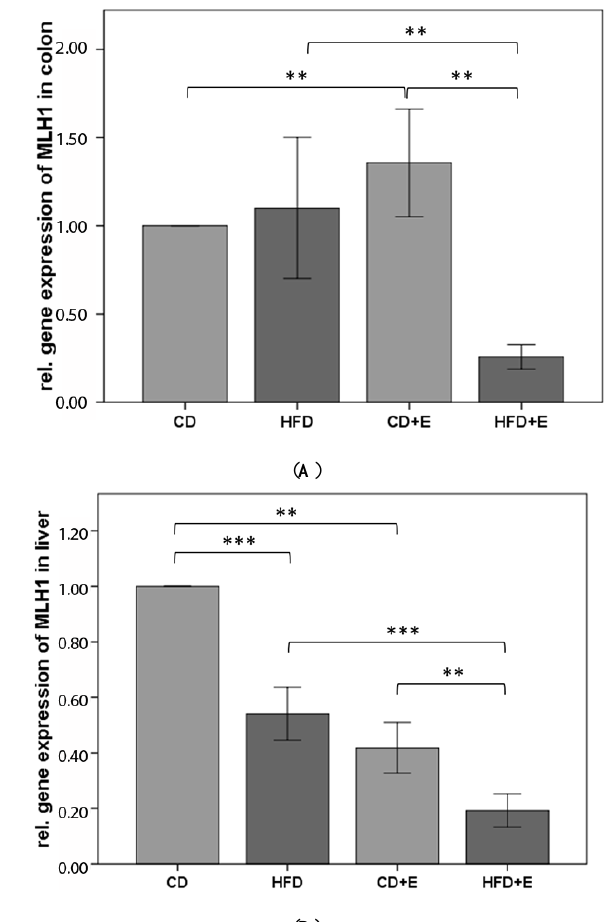
Figure 5. Relative gene expression of MLH1 in colon ( A ) and liver ( B ) of C57BL/6J male mice ( n = 15). Gene expression data were calculated relative to CD-data and normalized to the house keeping gene GAPDH. The error bar represents a 95% confidence interval. (CD = control diet; HFD = high fat diet; CD + E = control diet plus vitamin E; HFD + E = high fat diet plus vitamin E; ** p -value ≤ 0.01; *** p -value ≤